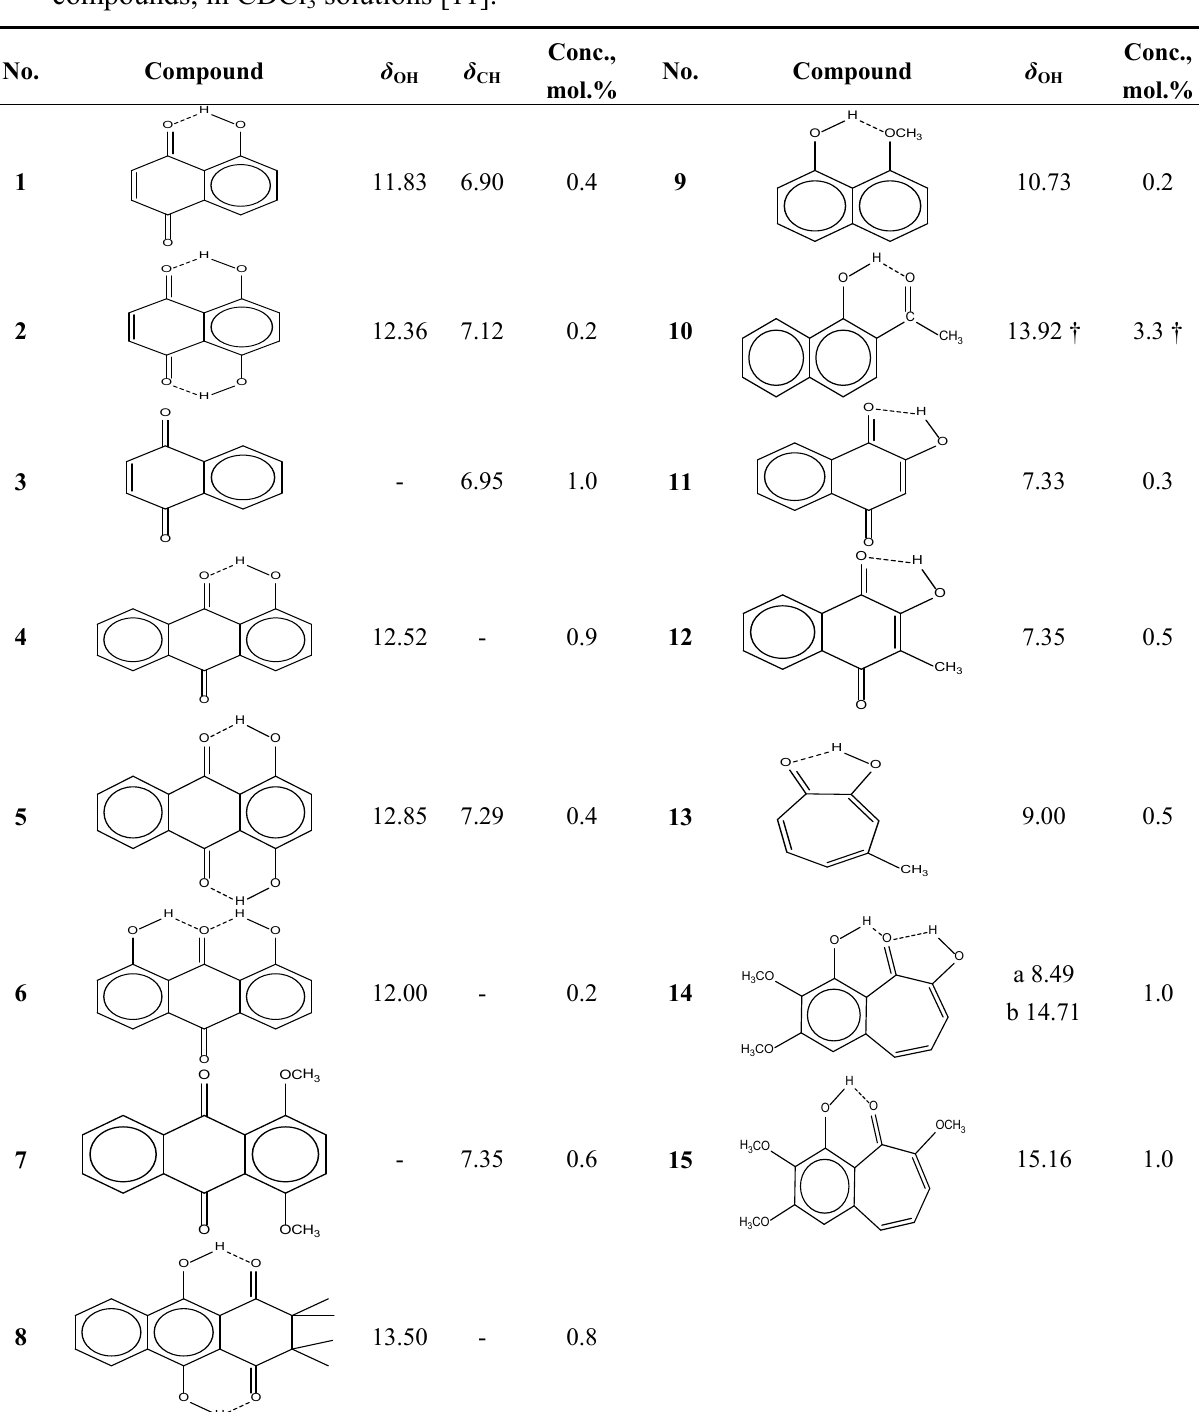
Table 1. Chemical shifts of OH ( δ compounds, in CDCl